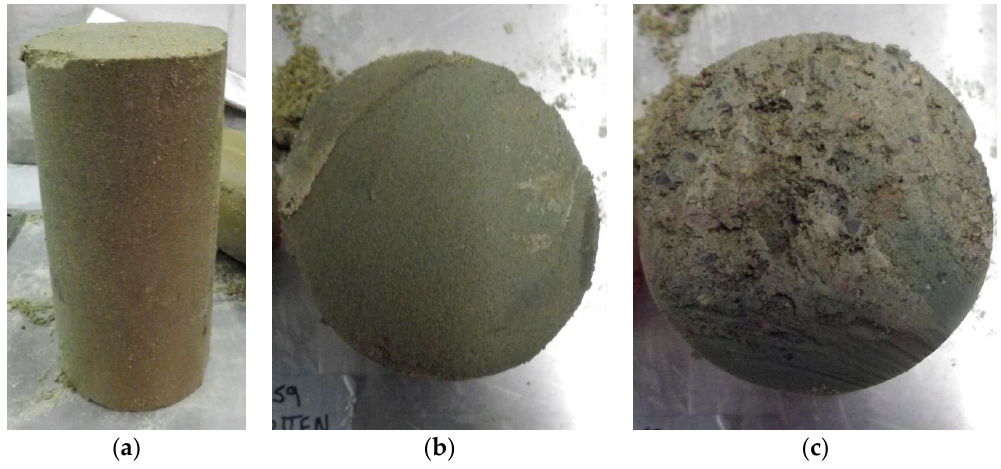
Figure 9. Possible problems of end flatness with cylindrical samples of cemented hydraulic backfill after ends are cut and ground: ( a ) piece detachment; ( b ) piece residue; ( c ) sand particle detachment.